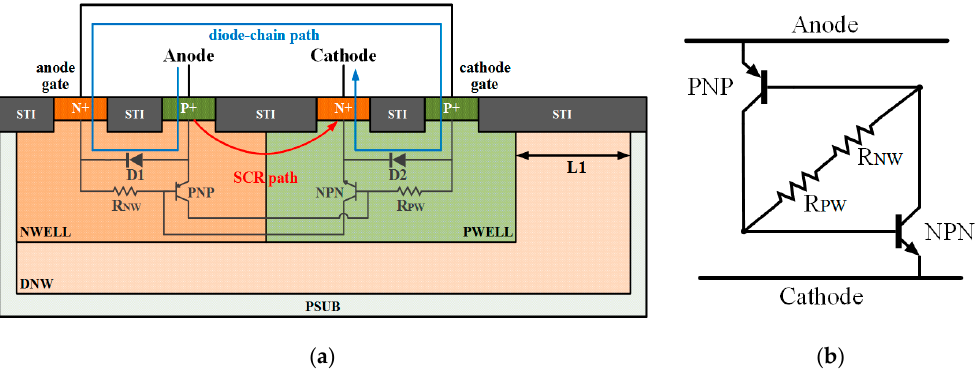
Figure 1. ( a ) Cross-sectional view of conventional DCSCR. The trigger path is illustrated by a blue arrow that is called the diode chain path; ( b ) Equivalent circuit diagram of conventional DCSCR.